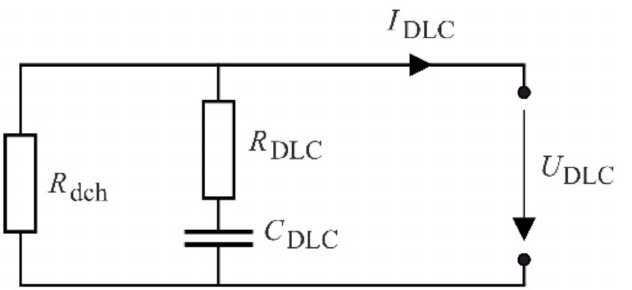
Figure 4. Equivalent electrical circuit for the double-layer capacitor-based energy storage